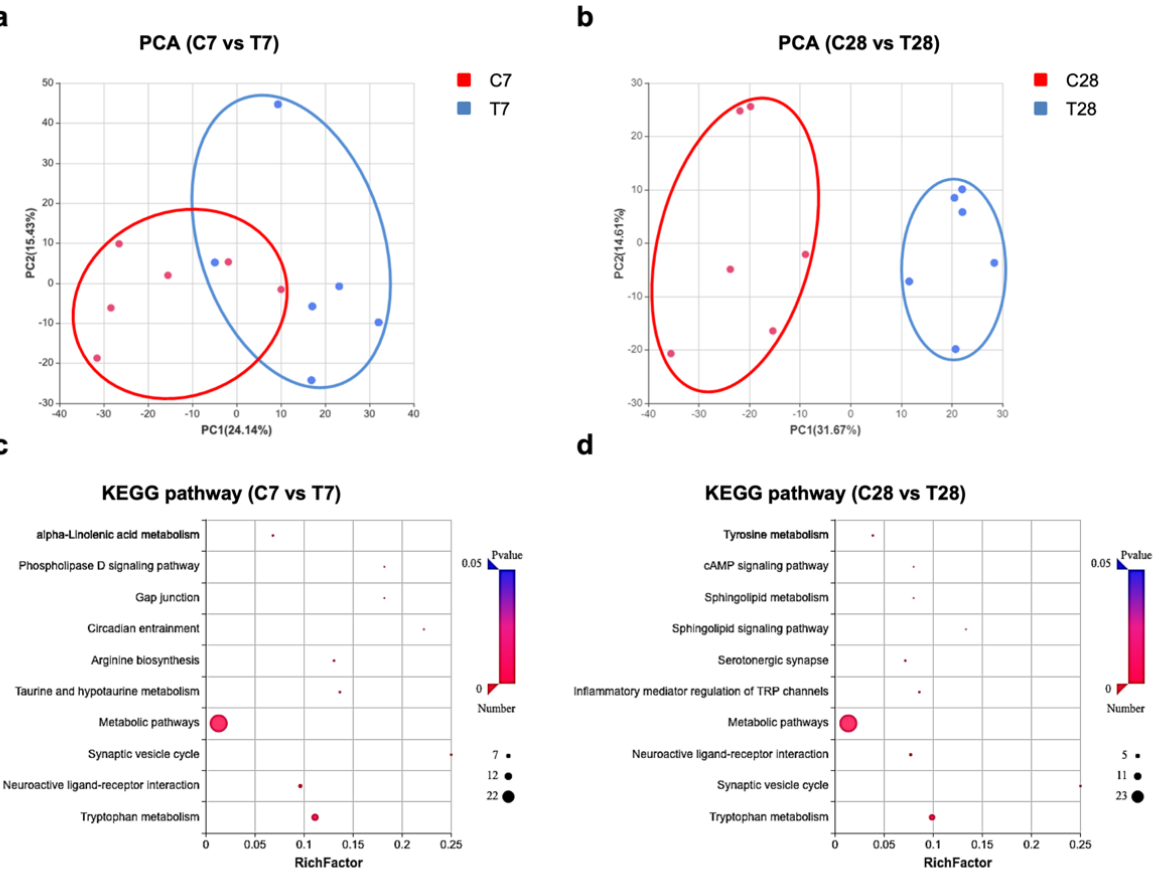
Figure 5. Untargeted metabolome analysis of serum post-TBI. PCA of the serum untargeted metabolic data at 7 days ( a ) and 28 days ( b ) post-TBI ( n = 6 per group). KEGG pathway enrichment analysis of differential metabolites in serum at 7 days ( c ) and 28 days ( d ) post-TBI ( n = 6 per group). TBI, traumatic brain injury; PCA, principal component analysis; KEGG, Kyoto Encyclopedia of Genes and Genomes.